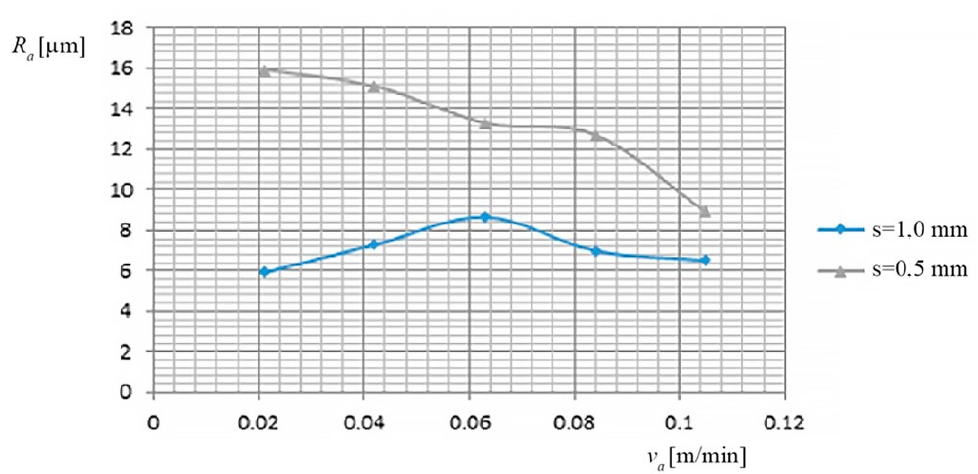
Figure 8. Dependence on the R a , the feed rate of the PO and the thickness of the metal band. Table 9. The dependence of the R a , on the feed rate of PO and on the thickness of the metal band. No. Table 10. The dependence of the thermal influenced zone, on the feed rate of PO and on the thickness of the metal band.